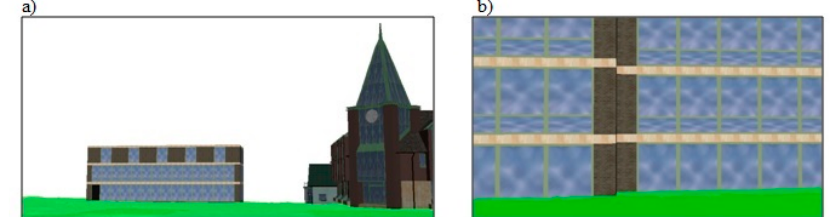
Figure 11. View for observation point number 47: ( a ) available view in scenario 1 ( b ) available view in scenario 2. Source: own work